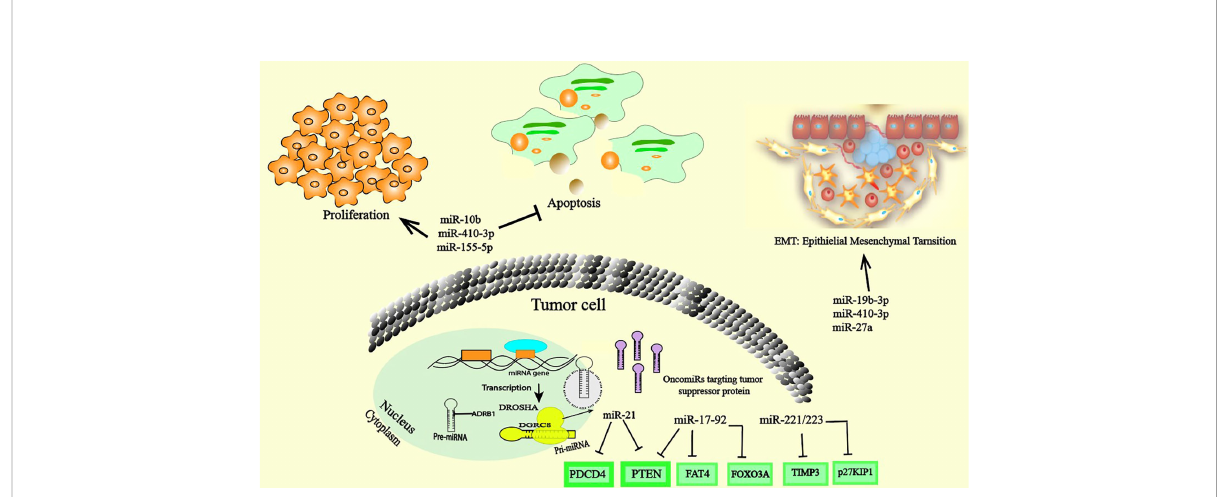
FIGURE 1 OncomiRs inside cancer cells. The overexpression of oncomiRs in cancer cells promote cancer through the regulation of the expression of multiple tumor suppressor gene targets with cancer-related cellular processes and/or genes that control cell differentiation, proliferation. OncomiRs can also enhance the EMT process, cell migration and